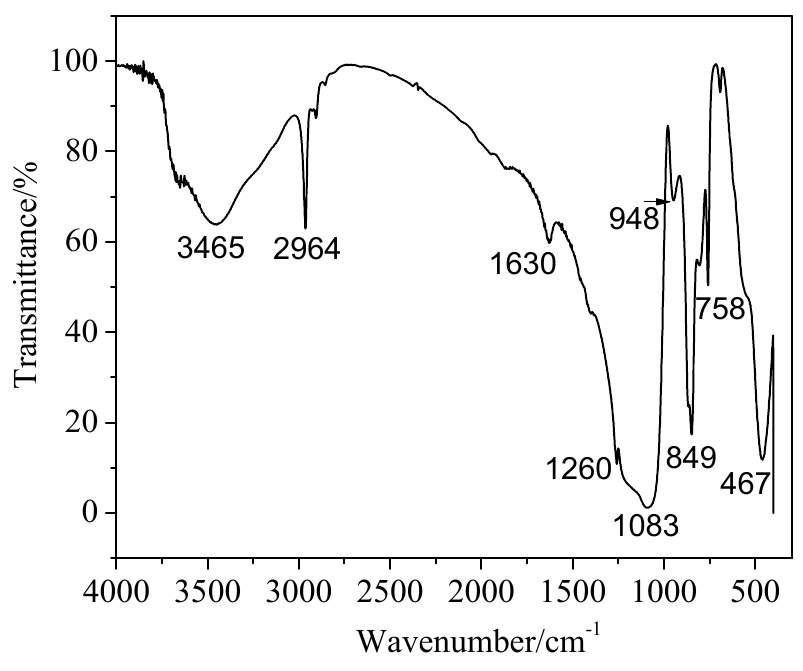
Figure 5. FT-IR spectra of SiO 2 aerogel powders. The relevant pore size distribution and N 2 adsorption–desorption isotherms of the silica aerogel powders are shown in Figure 6. The isotherm of this aerogel powder is close to a type IV; the adsorption branch slowly rises in the relatively small pressure region, which is monolayer adsorption. Most of the absorption occurs between relative pressures of 0.1 and 0.95, indicating a typical mesoporous structure. The specific surface area, pore size and pore volume of T aerogel are 748 m 2 /g, 7.04 nm and 1.64 cm 3 /g, respectively. The analysis of the pores was conducted by using BJH equilibrium model. Most of the pore sizes of aerogels ranged from 2 nm to 80 nm, which indicated that the aerogels prepared by this method were typical nanoscale mesoporous materials. Silica aerogel powders are thermal insulation